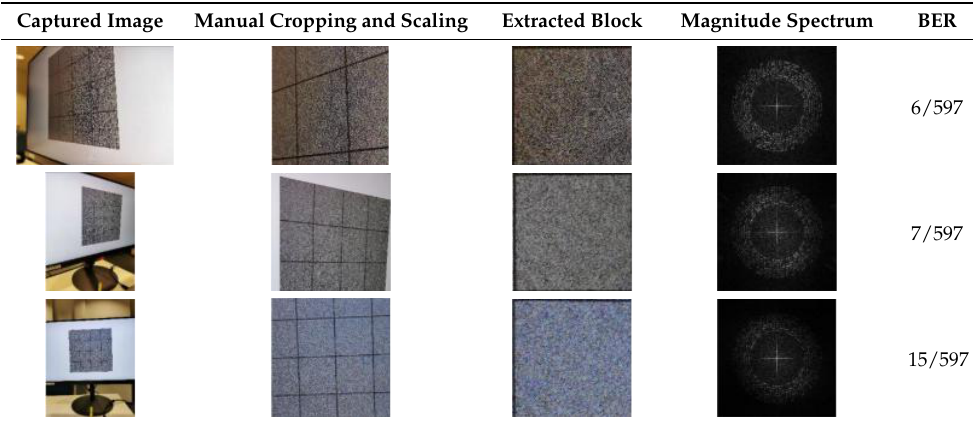
Table 6. Examples of extraction result of watermark B with manual